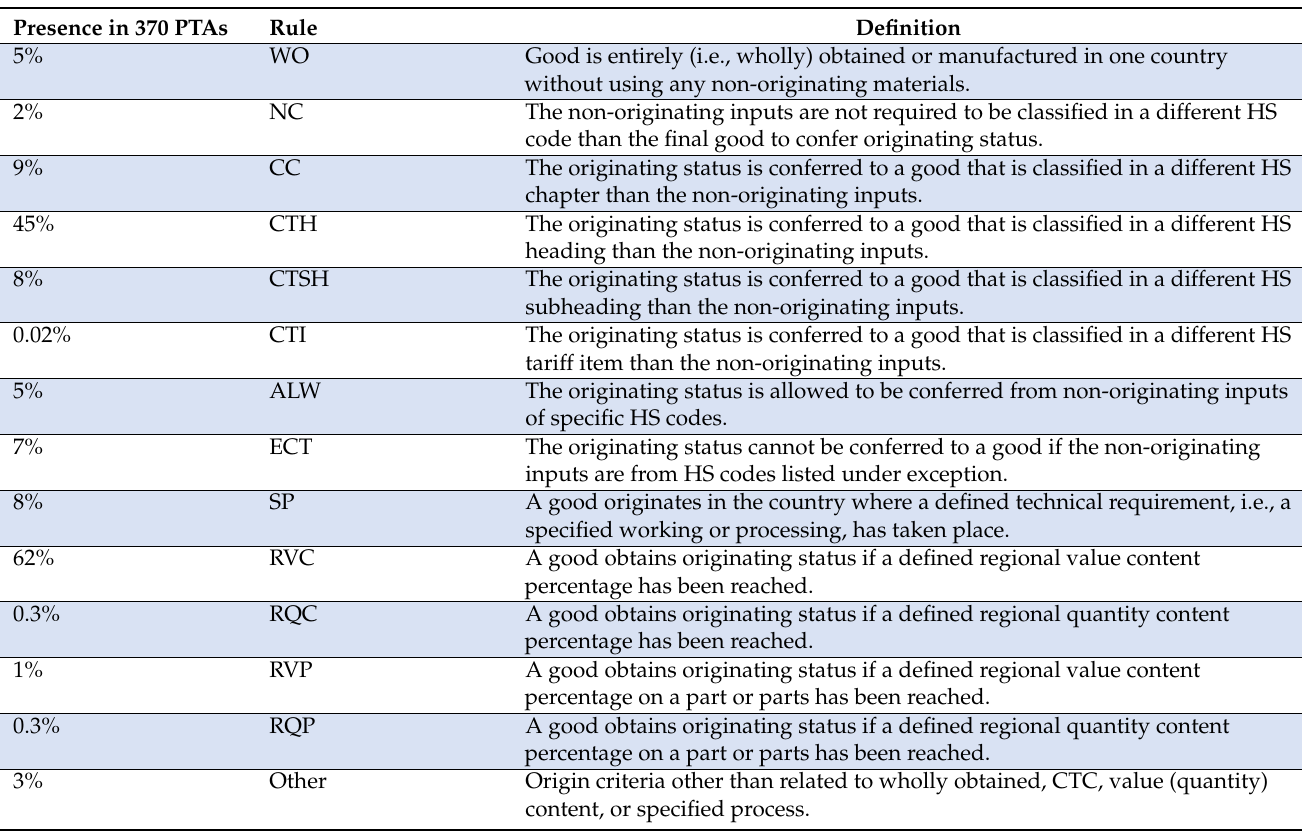
Table 2. The “building blocks” present in origin criteria in 370 PTAs.